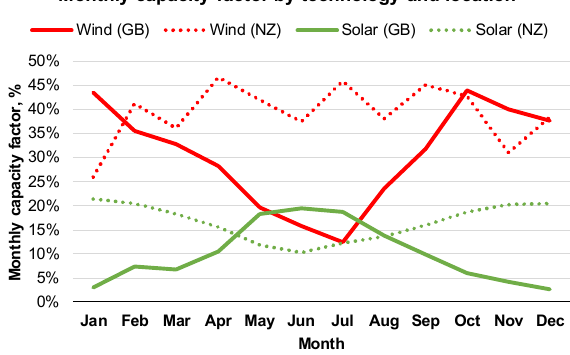
Figure 9. Capacity factor of wind and solar generation as modelled for New Zealand and Great Britain. Trends mirrored in (Ministry of Business, Innovation and Employment, 2019) (Ministry of Business, Innovation and Employment, 2019).